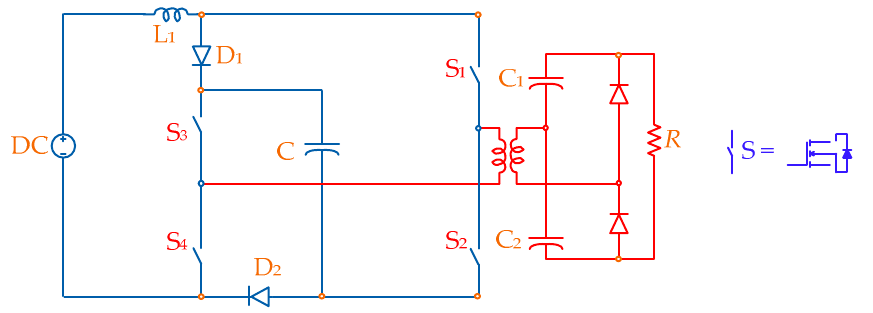
Figure 15. Isolated high step-up quasi-switched boost inverter.